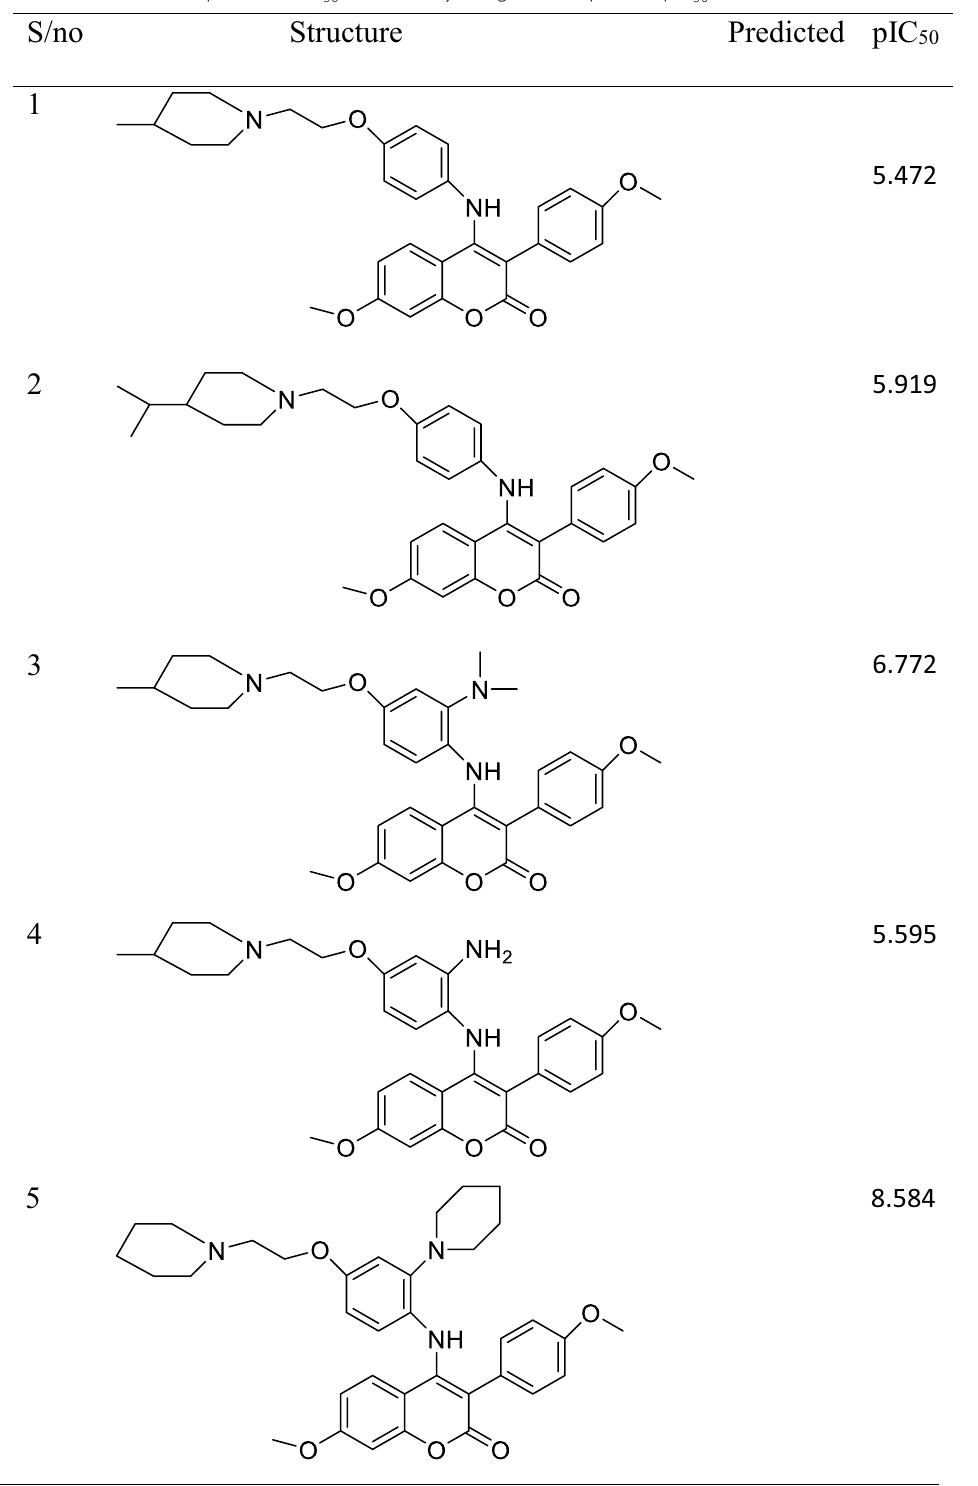
Table 6 Structure and predicted Pic